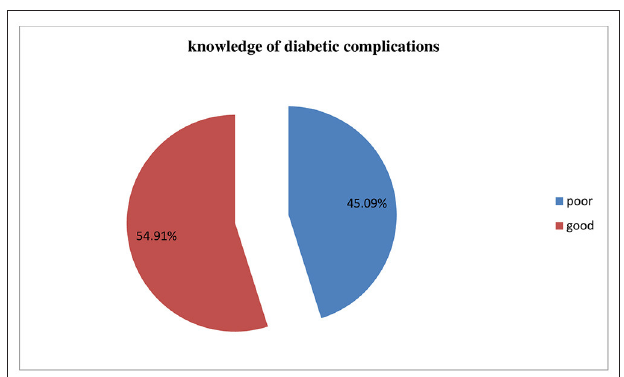
FIGURE 2 | Knowledge on diabetes mellitus complications among Type-2 diabetic patients in public hospitals of Addis Ababa, 2020.